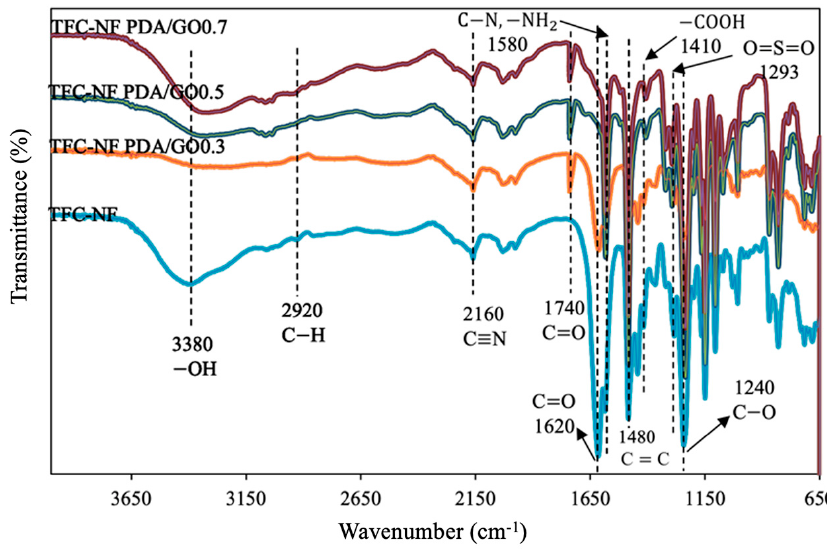
Figure 6. FTIR spectra of TFC NF membranes coated with different GO loading.